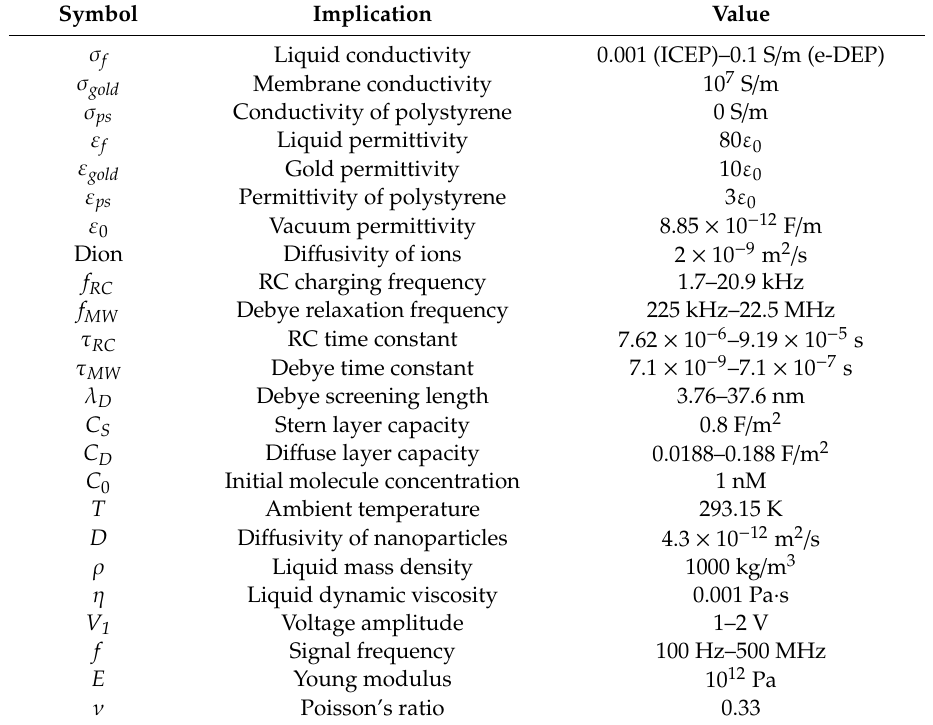
Table 3. Simulation parameters pertinent to the microfluidic device taking advantage of an array of Janus mobile microelectrodes for continuous loading and collection of surrounding biomolecules for potential biomedical